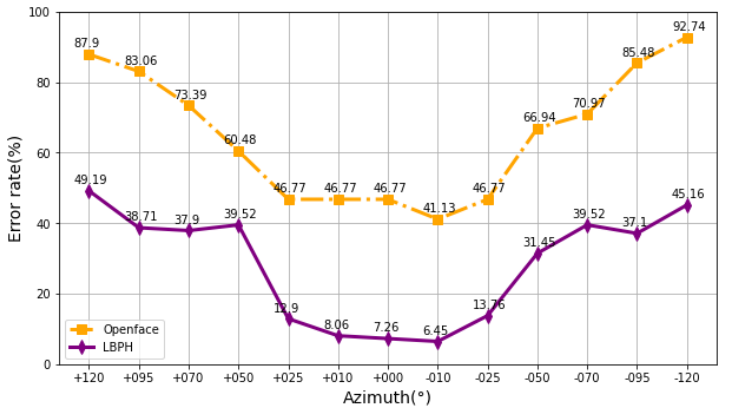
Figure 13. Average ambient light error rate of A+120– − 120E+00 group. With A+000° as the center line, the recognition error rate was almost symmetrical. both azimuth angles were in the range of +25° to − 25°, the recognition error rate was rela-